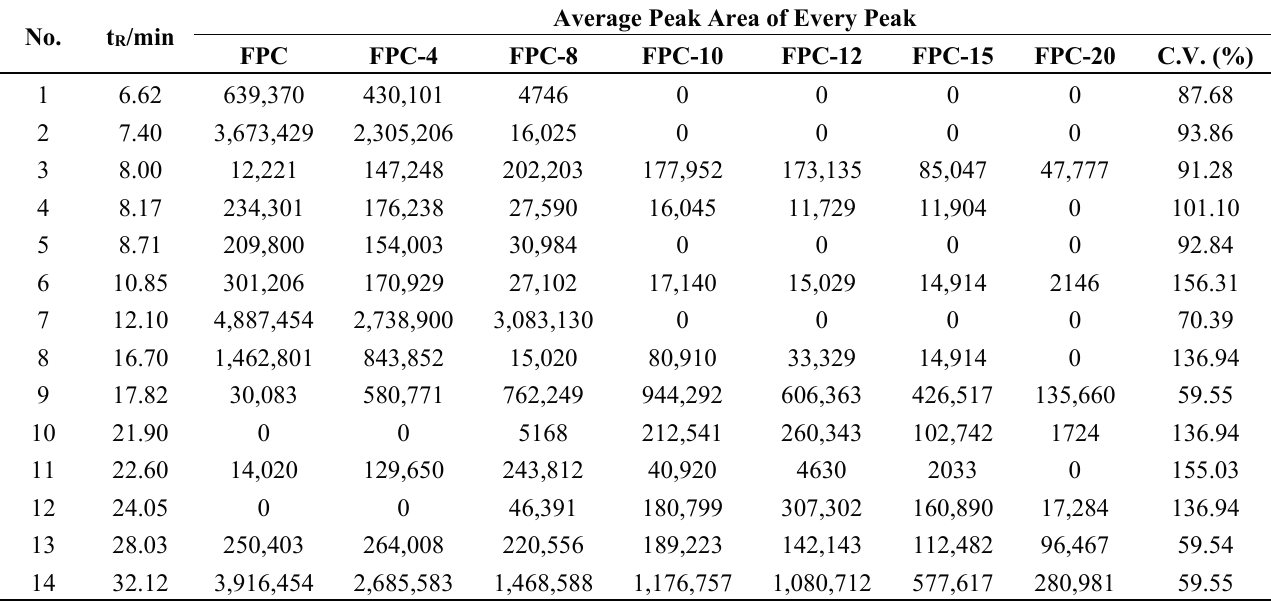
Table 2. Relative peak area of each peak of